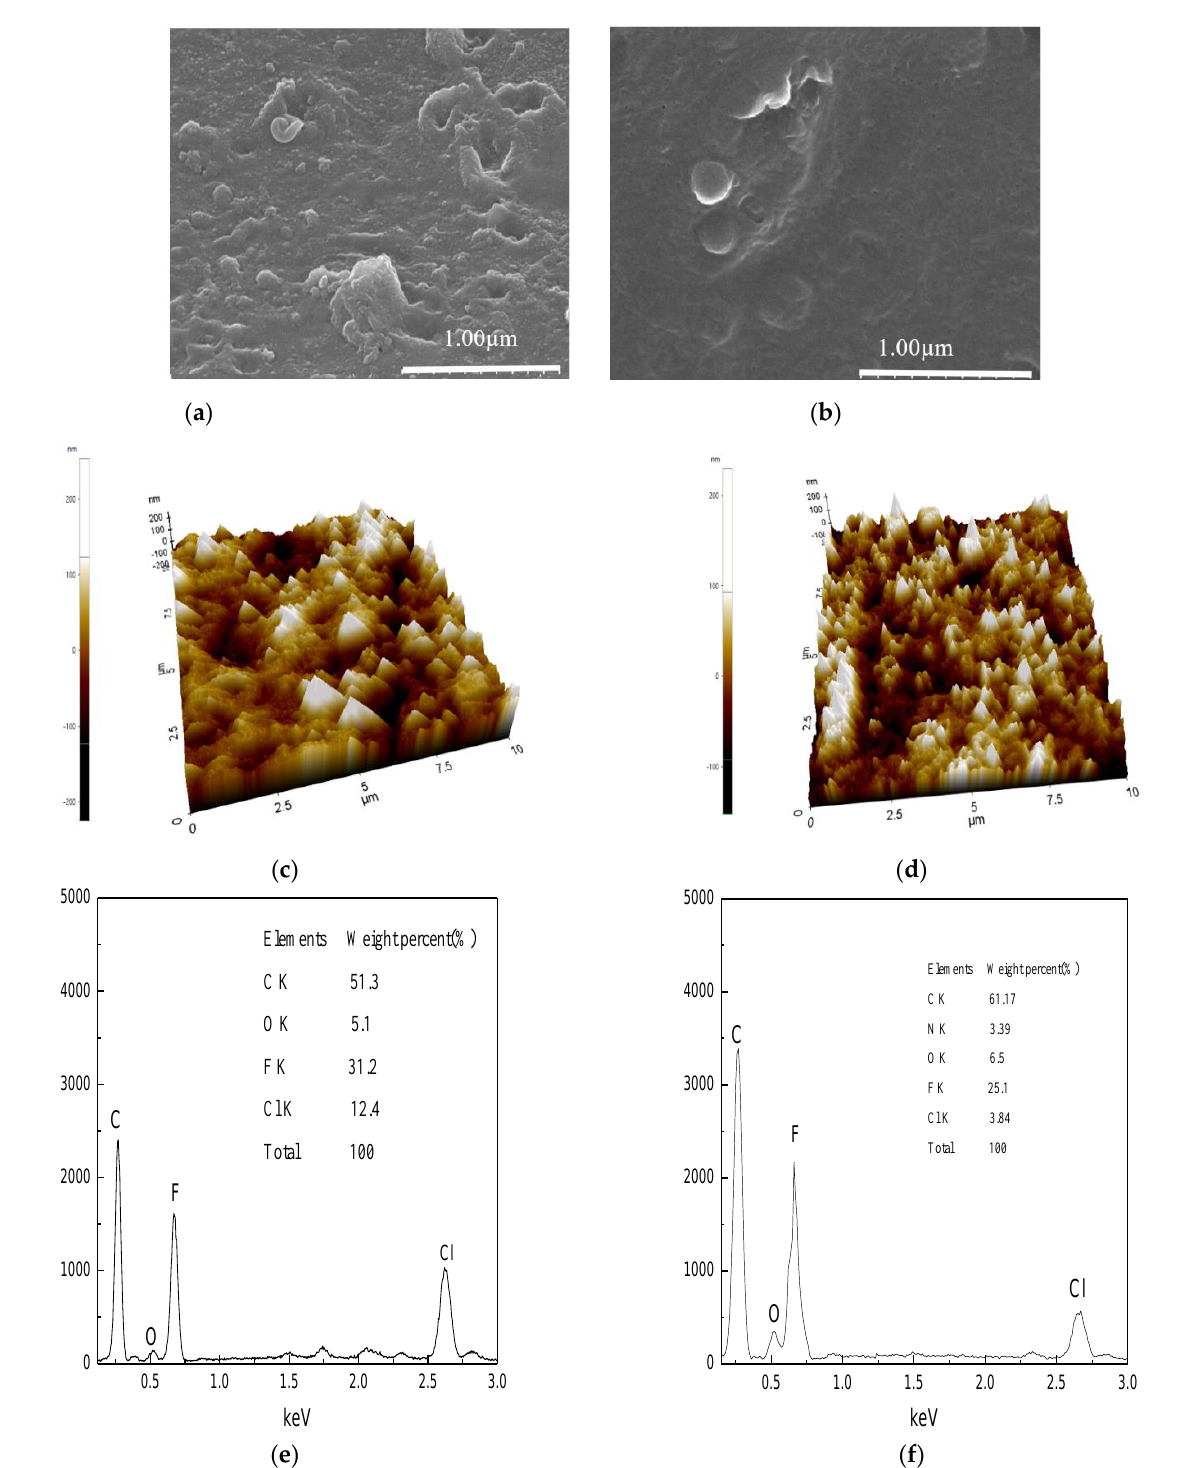
13 of 17 Figure 8. Loss rate of amino acids (black square) in the flask: 1 represents the data without mem- brane, 2 represents the data with membrane. 3.3. Analysis of Pristine and Fouled IEMs Finally, SEM, AFM, and EDS were employed to characterize the pristine and fouled ion exchange membranes. As shown in the SEM pictures (Figure 9A,B), compared with the pristine membrane (Figure. 9A), the surface of the membrane (Figure 9B) was covered with foulants. As analyzed in Figure 9 C (pristine) and D (fouled), the peaks of the mem- brane surfaces were 252.74 and 239.96 nm, respectively, and the roughness Ra were 46.875 and 37.02 nm, respectively. The reduction of membrane roughness after the desalination experiment suggested that a fouling layer was formed on the membrane surface, as shown in the previous study [39]. EDS analysis showed the elements detected on the membrane surface before and after the desalination process (Figure 9E,F). It was worth noting that the number of carbon atoms increased from 51.314% (pristine membrane, Figure 9E) to